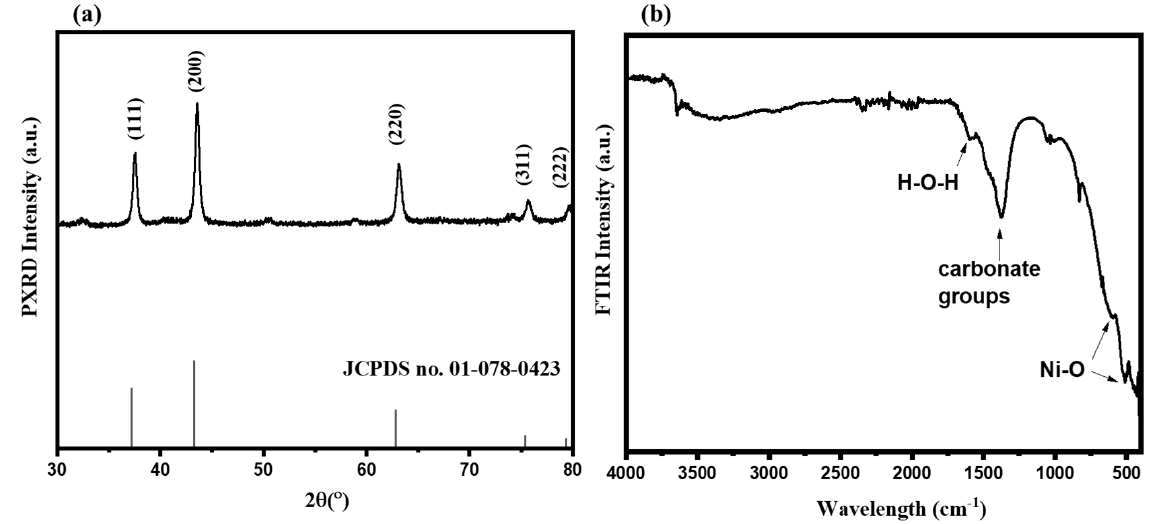
Figure 1. ( a ) PXRD pattern and ( b ) FTIR of NiO.